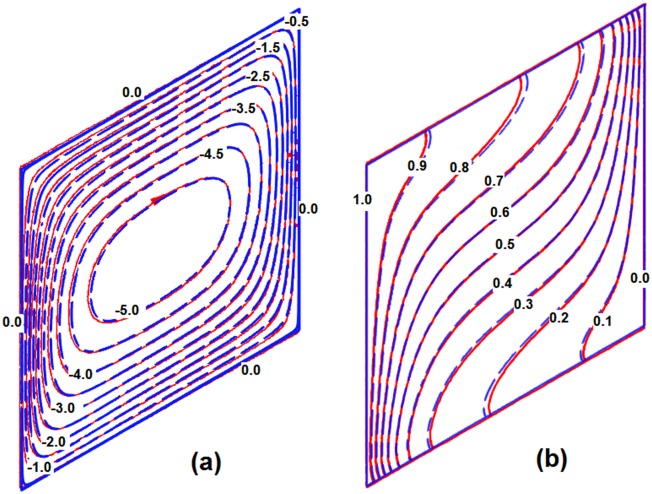
Stream lines (a) and isotherms (b) when α = 30°, A = 1 and Ra = 100: the blue with dashed lines is the present study and the solid red lines are Costa [20] (a) and (b)